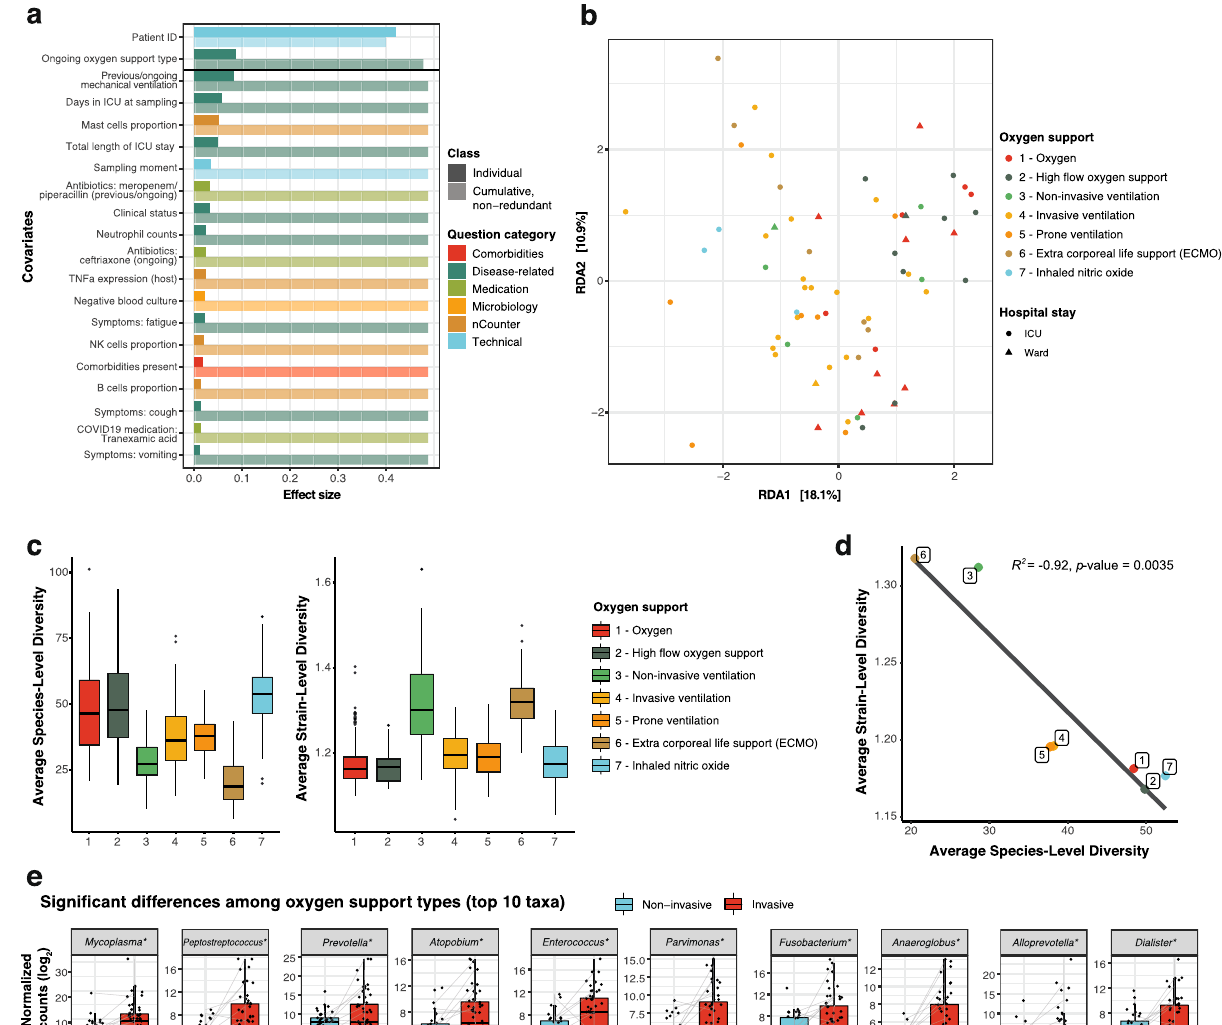
Fig. 2 Upper respiratory microbiome covariates in COVID-19. a Signi fi cant (BH-corrected p value < 0.05) covariates explaining microbiota variation in the upper respiratory tract in this cohort ( n = 101 samples, dbRDA). Individual covariates are listed on the y-axis, their color corresponds to the metadata category they belong to. Darker colors refer to the individual variance explained by each of these covariates assuming independence, while lighter colors represent the cumulative and nonredundant variance explained by incorporating each variable to a model using a stepwise dbRDA analysis. The black horizontal line separates those variables that are signi fi cant in the nonredundant analysis on top (Patient ID and oxygen support type) from the rest. b RDA ordination plot showing the fi rst two constrained axes. Ordination is constrained by the two signi fi cant variables “ Patient ID ” and “ Oxygen support ” . Samples are depicted as points, whose color indicates the oxygen support type of the patient and whose shape indicates stay at ward or ICU (during sampling). Axes indicate the variance explained by the fi rst two constrained components of the dbRDA analysis. c Species- (left) and strain-level diversity (right) of the samples, strati fi ed by oxygen support type ( n = 101 samples). d Pearson correlation between average species- and strain- level diversity for each of the oxygen support categories. The R 2 and the p value (two-sided F -test) from a linear regression between the two variables are shown. e . Signi fi cant differences in taxa abundances among oxygen support types ( n = 101 samples). Differentially abundant taxa between invasive (red) and noninvasive (blue) ventilated samples. Only the top 10 most signi fi cant taxa are shown, as determined by their BH-adjusted p value. Boxplots span from the fi rst until the third quartile of the data distribution, and the horizontal line indicates the median value of the data. The whiskers extend from the quartiles until the last data point within 1.5 times the interquartile range, with outliers beyond. Individual data points are also represented. Gray lines join samples pertaining to the same patient, taken at different timepoints. Asterisks (*) indicate taxa that remain signi fi cant after controlling for the main antibiotics (ceftriaxone and meropenem/piperacillin-tazobactam). Source data are provided as a Source Data fi